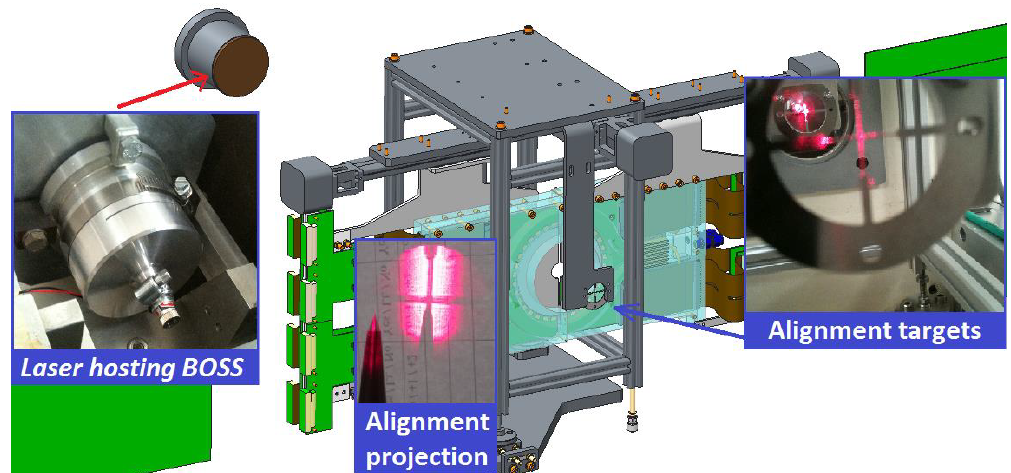
Figure 3. Frame of the VELO modules on the bottom base. Alignment laser and targets allow the alignment in the beam axis [16].